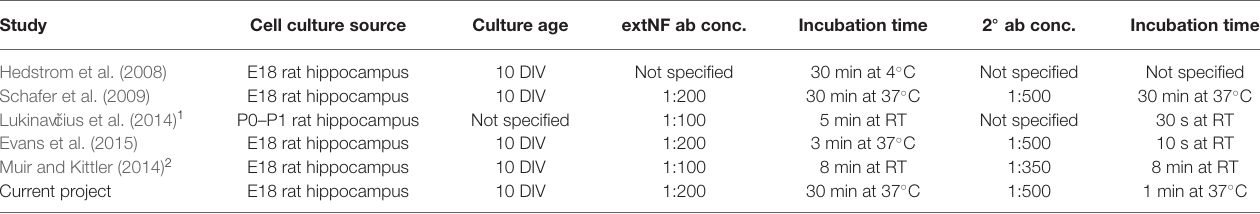
TABLE 1 | List of publications that have used extNF as a live axon initial segment (AIS)